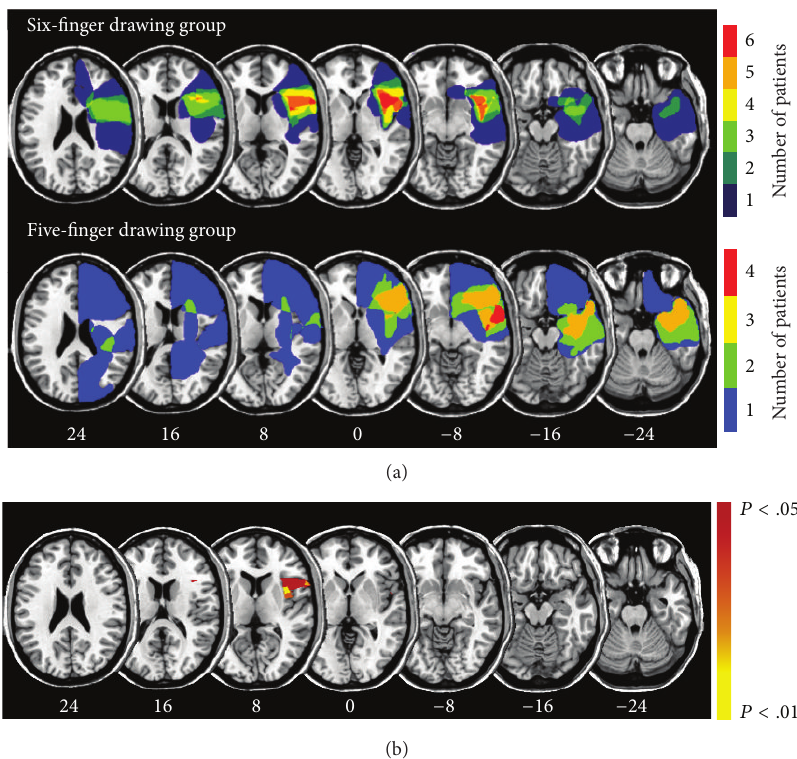
Figure 4: Lesion analysis for the six-finger drawing group. (a) Lesion overlap between six-finger and five-finger drawing groups (upper and middle images). (b) Brain areas revealed by statistical analysis as differing between the six-finger and five-finger drawing